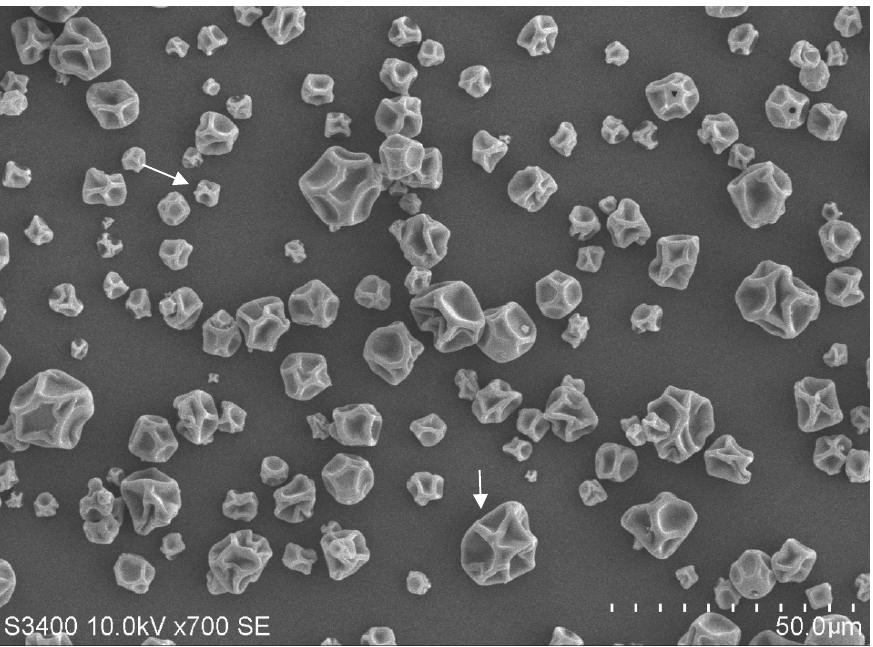
Figure 2. Microparticles of Bdellovibrio powder. Arrows show the spherical microparticles with a wrinkled surface.